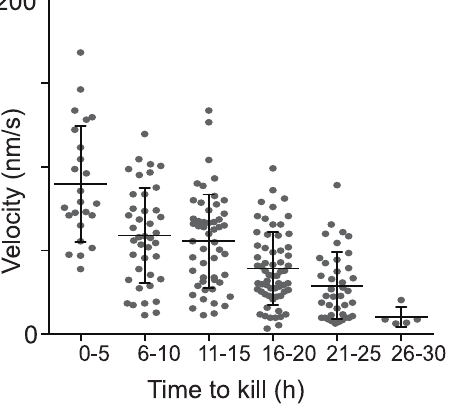
Figure 7. Velocity of a CTL directly correlates with its ability to kill. CTL were isolated from OVA-immunised mice and underwent short stimulation with antigen in vitro before adding to KC monolayers loaded with SIINFEKL and imaged for 30 h. Movies were examined in 5- hour time intervals to analyse target cell death in that time frame, and its killer CTL identified. If more than one CTL was attached to a dying KC, both were analysed. The average track velocity for each identified CTL in each time interval was determined. CTL which were not moving, were excluded. Pooled results N=3 independent experiments. Mean and SD are shown.